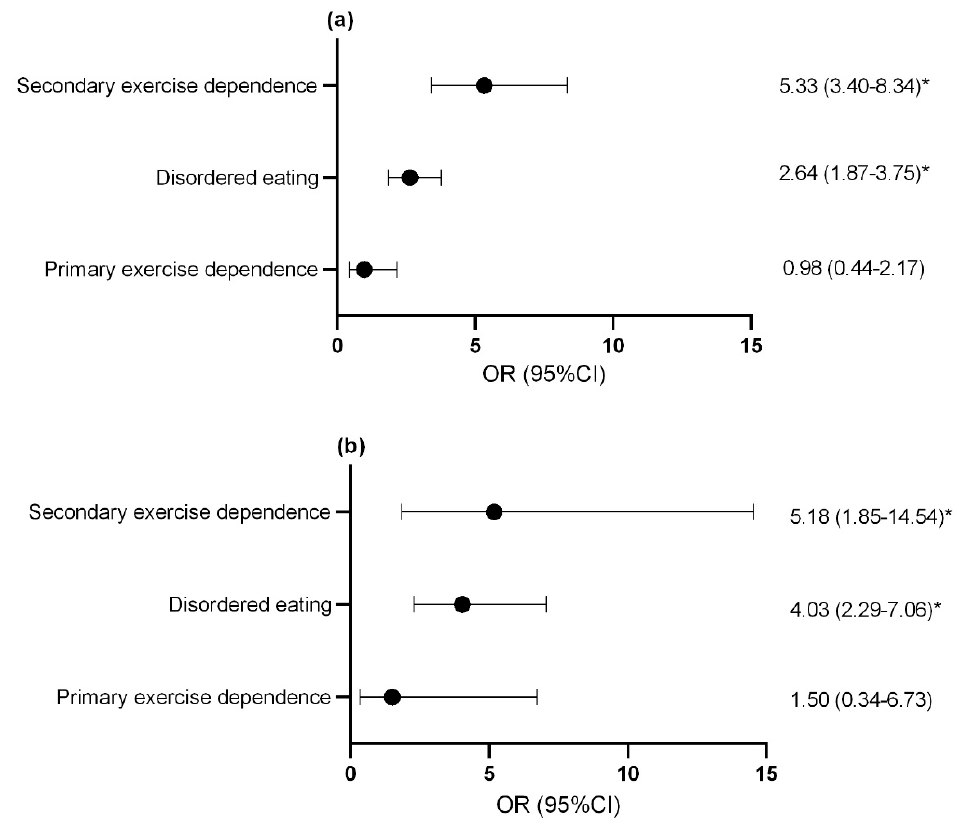
Figure 3. Odds ratio and confidence interval of increased gas and bloating in ( a ) females and ( b ) ( b ) males with disordered eating and exercise dependence status. * p < 0.05. OR, odds ratio; CI, males with disordered eating and exercise dependence status. * p < 0.05 . OR, odds ratio; CI, confi- confidence dence interval.